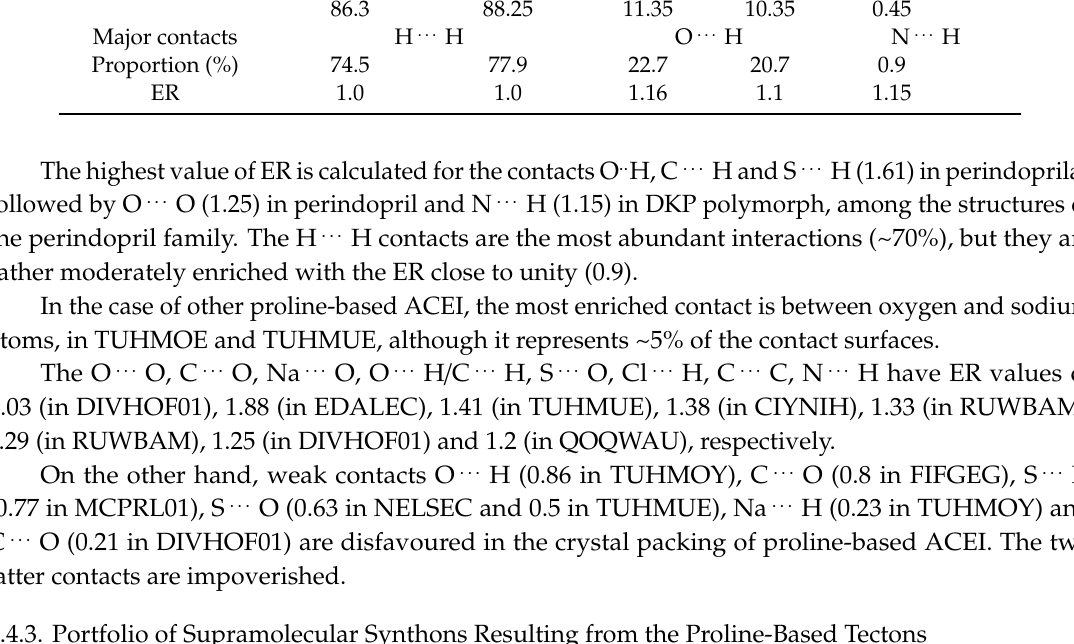
Table 3. Major interactions, proportions on the HS and ER for perindoprilat structures. Interactions BECWIR FEFKEI Surface (%) H O C S 61.95 81.4 18 18.05 0.45 0.45 0.7 - Major contacts H ... H O ... H C ... H S ... H Proportion (%) 60.8 62.9 36 36.1 0.9 0.9 1.4 - ER 1.58 0.95 1.61 1.23 1.61 1.23 1.61 - Table 4. Major interactions, proportions on the HS and ER for DKP perindopril polymorphs. Interactions BILNAN BILNAN01 Surface (%) H O N 86.3 88.25 11.35 10.35 0.45 Major contacts H ... H O ... H N ... H Proportion (%) 74.5 77.9 22.7 20.7 0.9 ER 1.0 1.0 1.16 1.1